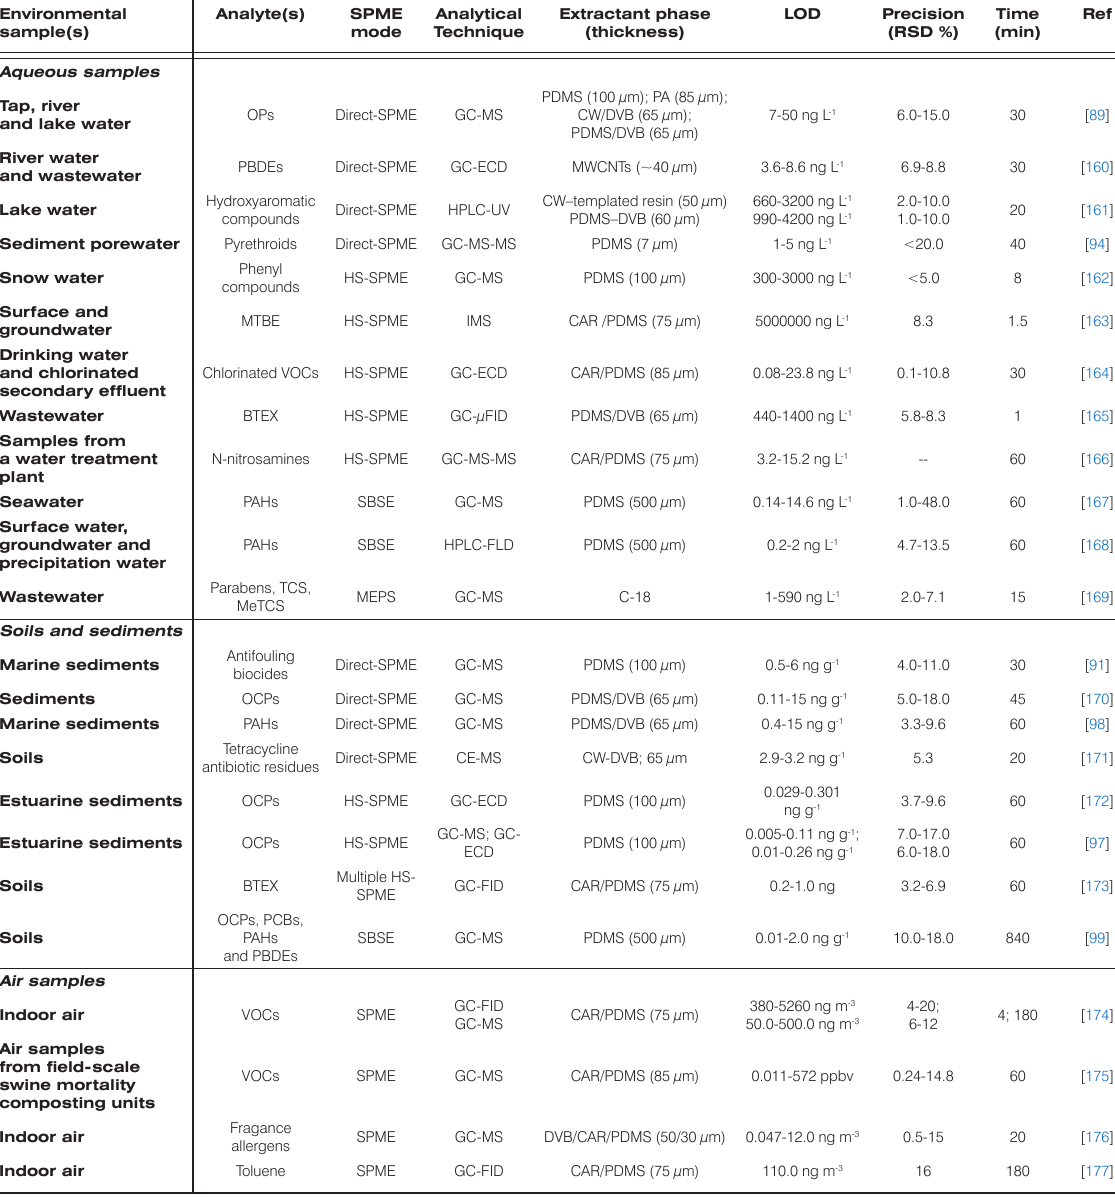
Table 1. Selected applications of SPME and related techniques to the determination of organic compounds in environmental samples. Environmental